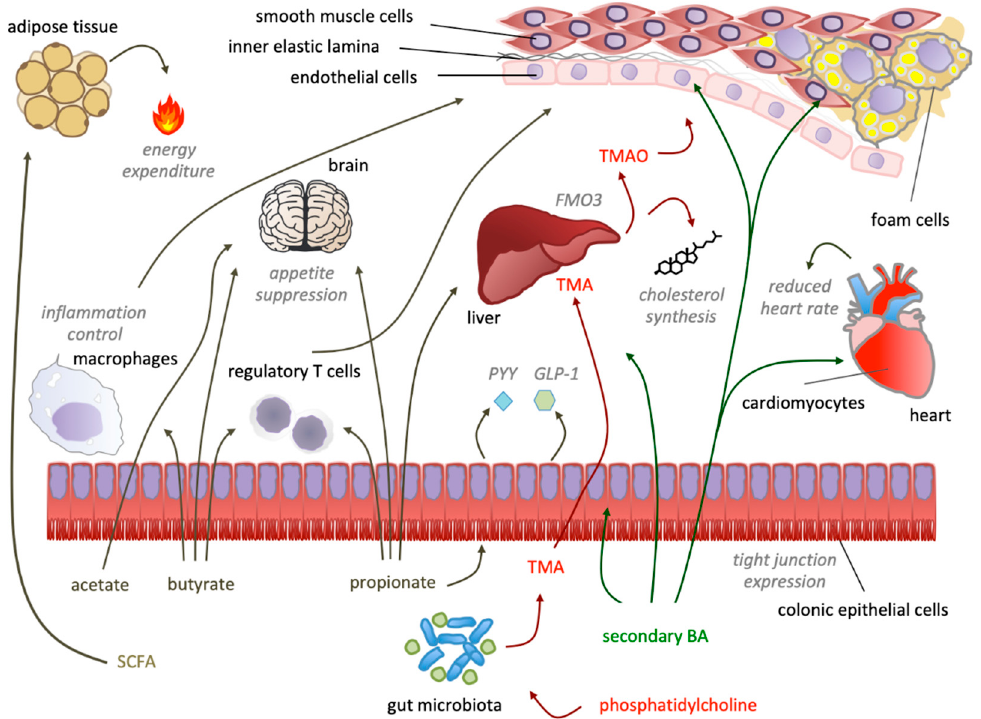
Figure 3. The gut microbiota synthesizes hormone-like molecules that can influence the development of cardiovascular disease. SCFA produced by microbiota (dark yellow) have pleiotropic effects that modulate gut endothelial cells permeability, inflammatory cells activation, glucose tolerance and satiety—ultimately impacting on cardiovascular disease. Hepatic (primary) bile acids are metabolized in the gut into secondary bile acids, that act as long-range signaling molecules (dark green) with e ff ects on heart rate, cholesterol synthesis and gut epithelium integrity. The metabolism of choline-containing compounds supplies the liver with trimethylamine (TMA, dark red), which is oxidized by hepatic FMO3 into TMAO, exacerbating atherosclerosis development.